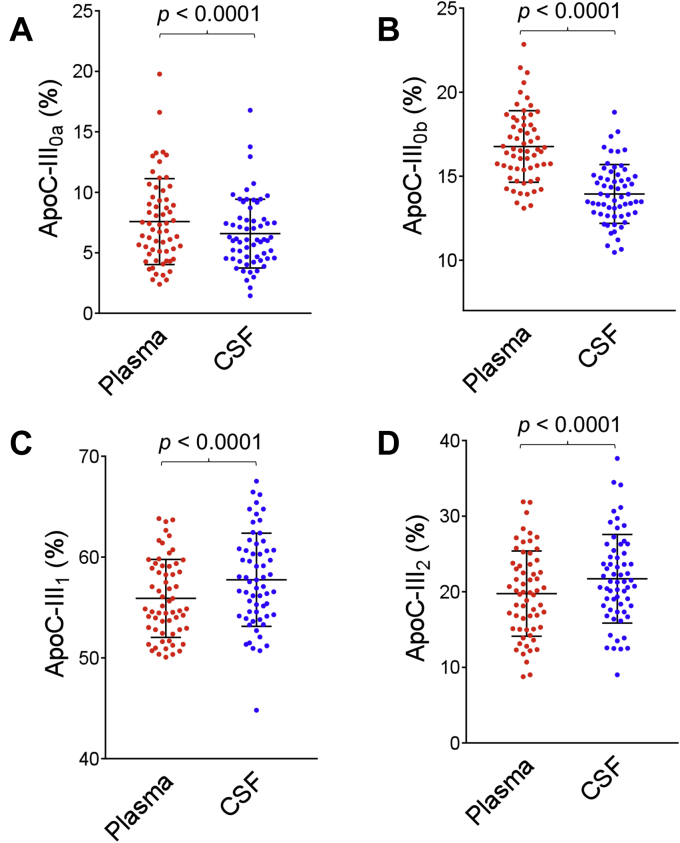
Percent abundance of: (A) apoC-III0a (B) apoC-III0b (C) apoC-III1, and (D) apoC-III2 in plasma versus CSF. Percent abundance was computed by dividing the peak area of each isoform with the summed peak areas of all apoC-III isoforms. Parametric paired t-test was performed to identify differences between plasma and CSF samples for normally distributed data sets (apoC-III0b and apoC-III2). Nonparametric Wilcoxon matched-pairs signed rank test was applied to data sets that were not normally distributed (apoC-III0a and apoC-III1).